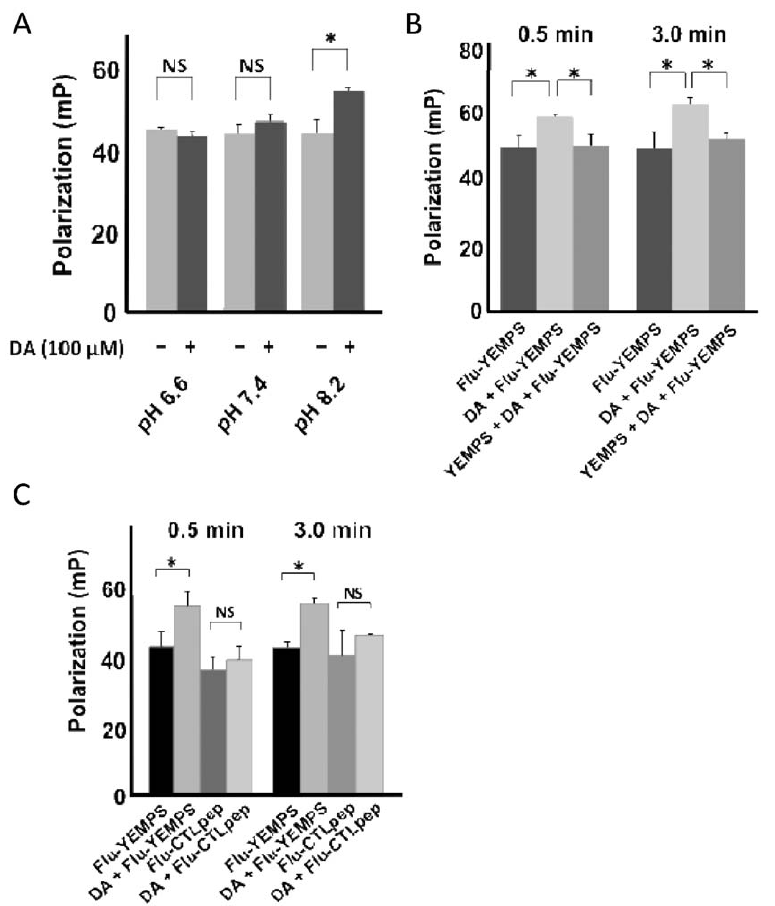
Figure. 2. Interaction of DA with 125YEMPS129 measured by alterations in fluorescent anisotropy. (A) The anisotropic signal of the Flu- YEMPS peptide was altered by co-incubation with DA (100 m M, 3 min) at alkaline pH. *p , 0.01 (ANOVA), NS: significant. (B) Non-labeled YEMPS competitively inhibited the DA-induced (100 m M, pH 8.2) alteration of the anisotropic signal of Flu-YEMPS *p , 0.01. (C) The anisotropic signal of the Flu-120PDNEA124 control peptide (CTLpep) was not altered by the presence of DA (100 m M, pH 8.2) *p , 0.01, NS: not